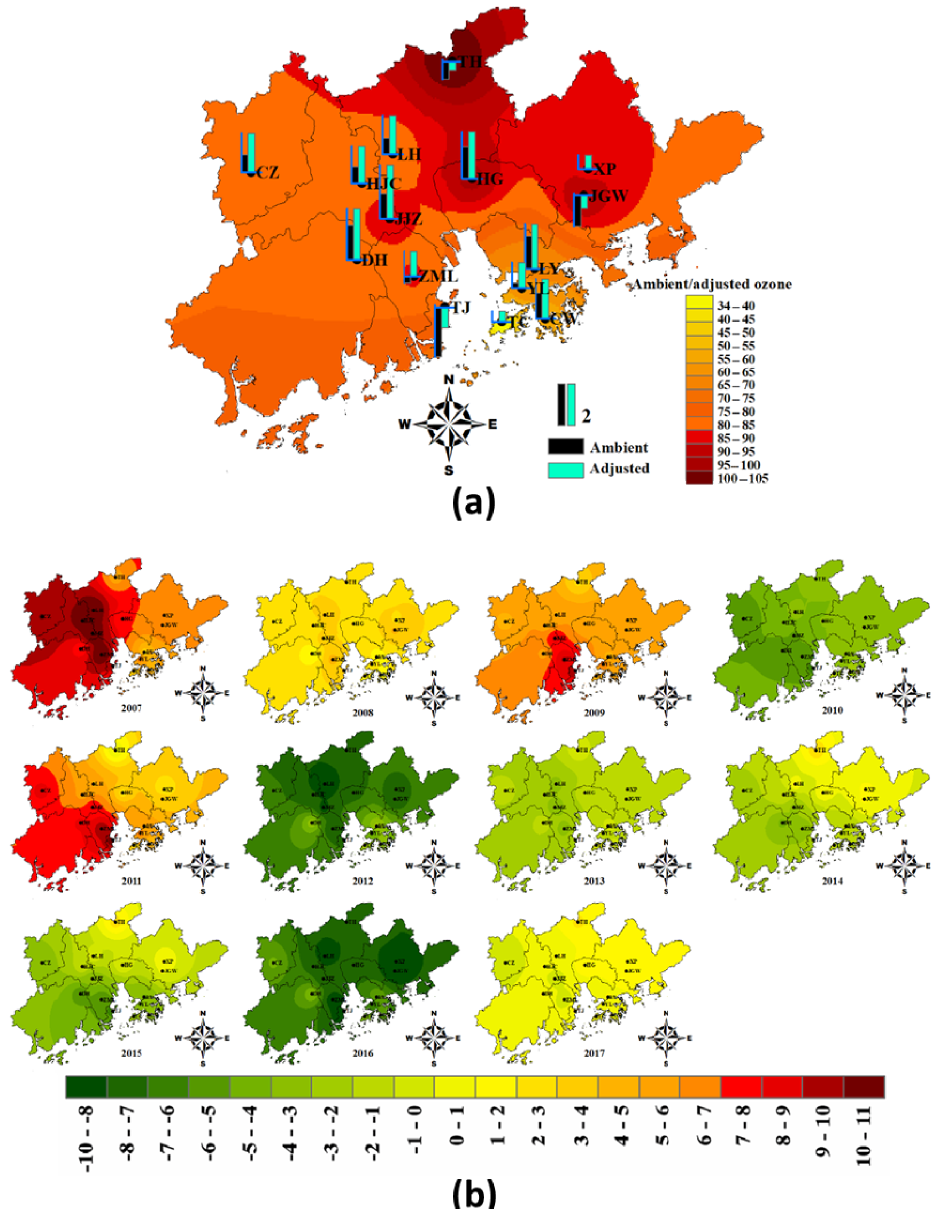
Figure 4. (a) The spatial distribution of averaged ozone concentrations (µgm − 3 ) in the Pearl River Delta and annual ozone changes (µgm − 3 yr − 1 ) before and after meteorological adjustment over the 15 monitoring stations during the 2007–2017 period. The bar length in the legend corresponds to an annual increase of 2µgm − 3 . (b) The annual variation of the meteorological impact on the ozone concen- tration (µgm − 3 ) over the Pearl River Delta during the 2007–2017 period. The legend of the colored contours in (a) refers to the ozone concentration (µgm − 3 ) isopleths before and after meteorological